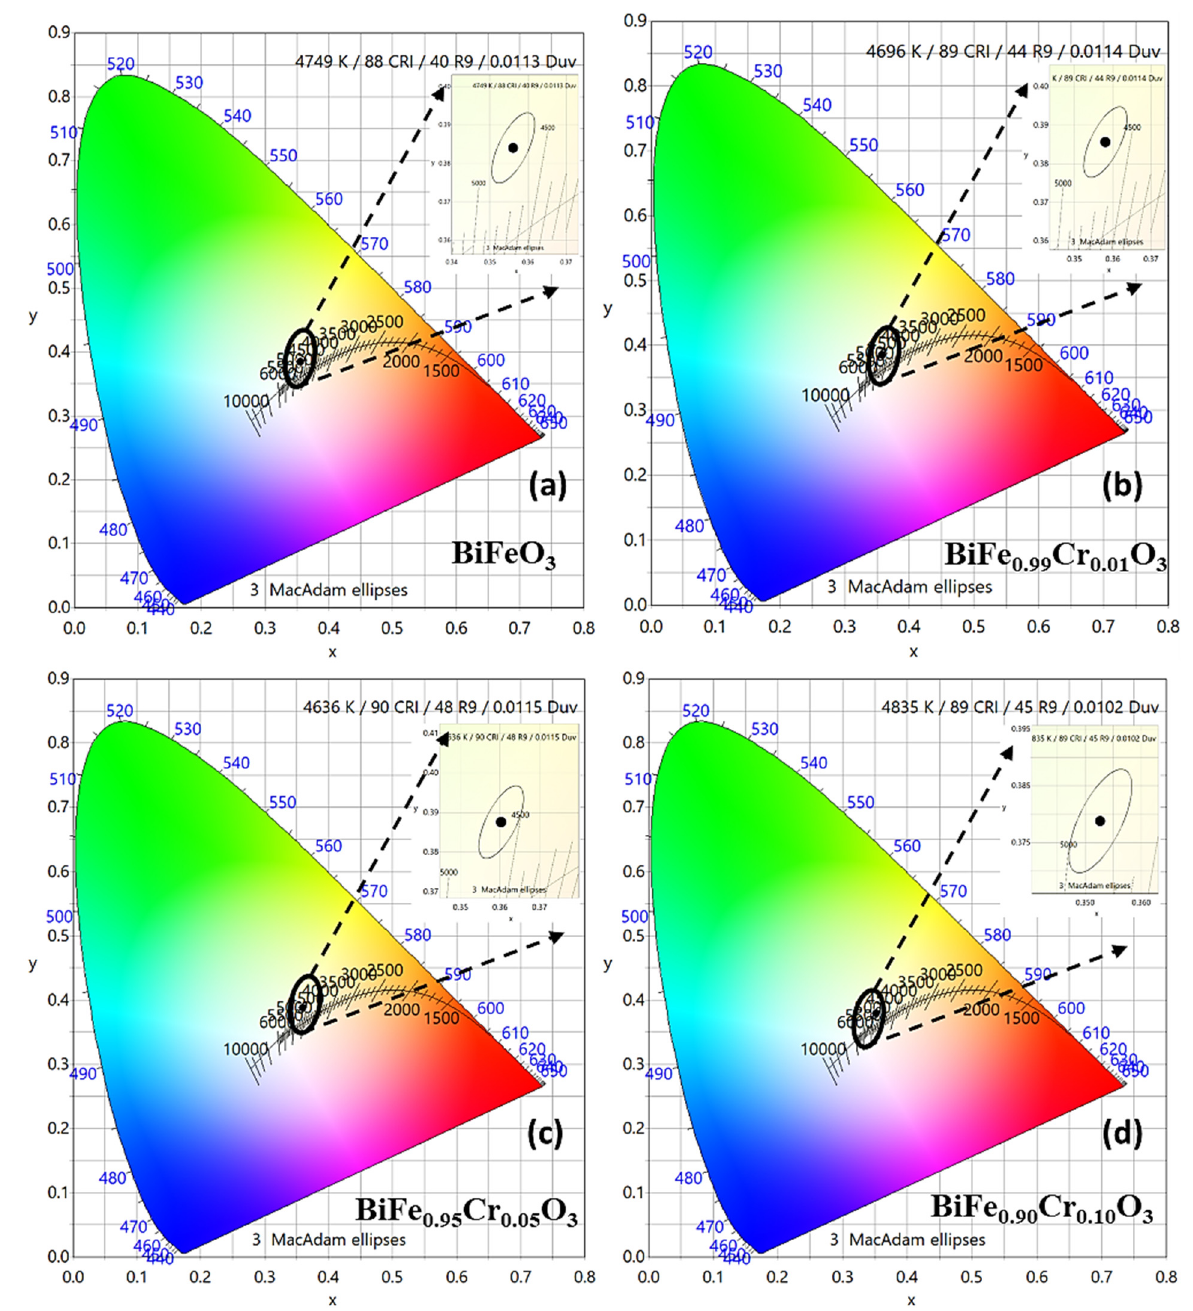
Figure 7. ( a – d ) CIE 1931 chromaticity diagram of BiFe 1 − x Cr x O 3 (0 < x < 10) nanoparticles in the range 300–700 nm; respective insets show the enlarged views of the emitted colors shown by the elliptical dots.